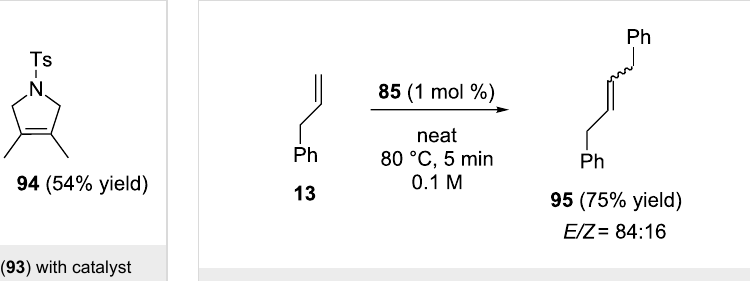
Scheme 10: RCM of N,N -dimethallyl- N -tosylamide ( 93 ) with catalyst 85 .